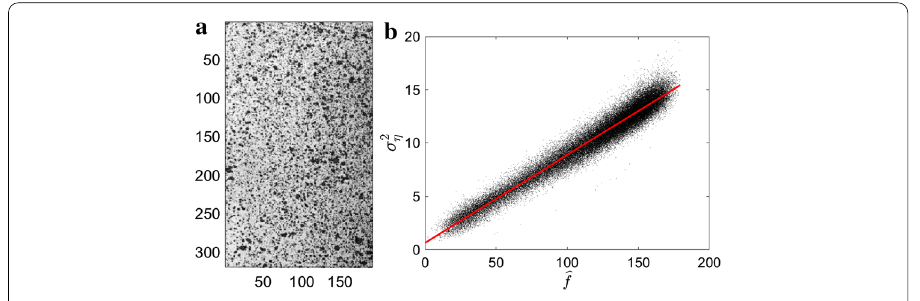
Fig. 12 a Denoised picture (cid:2) f in the reference configuration of the virtual test case. b Variance of acquisition noise σ 2 η as a function of the gray level of the denoised picture. (cid:2) f is constructed by using an actual picture series of the uncertainty analyses. Its definition is 320 × 192 pixels. The acquisition noise is Poissonian since its variance is proportional (solid red line) to the considered gray